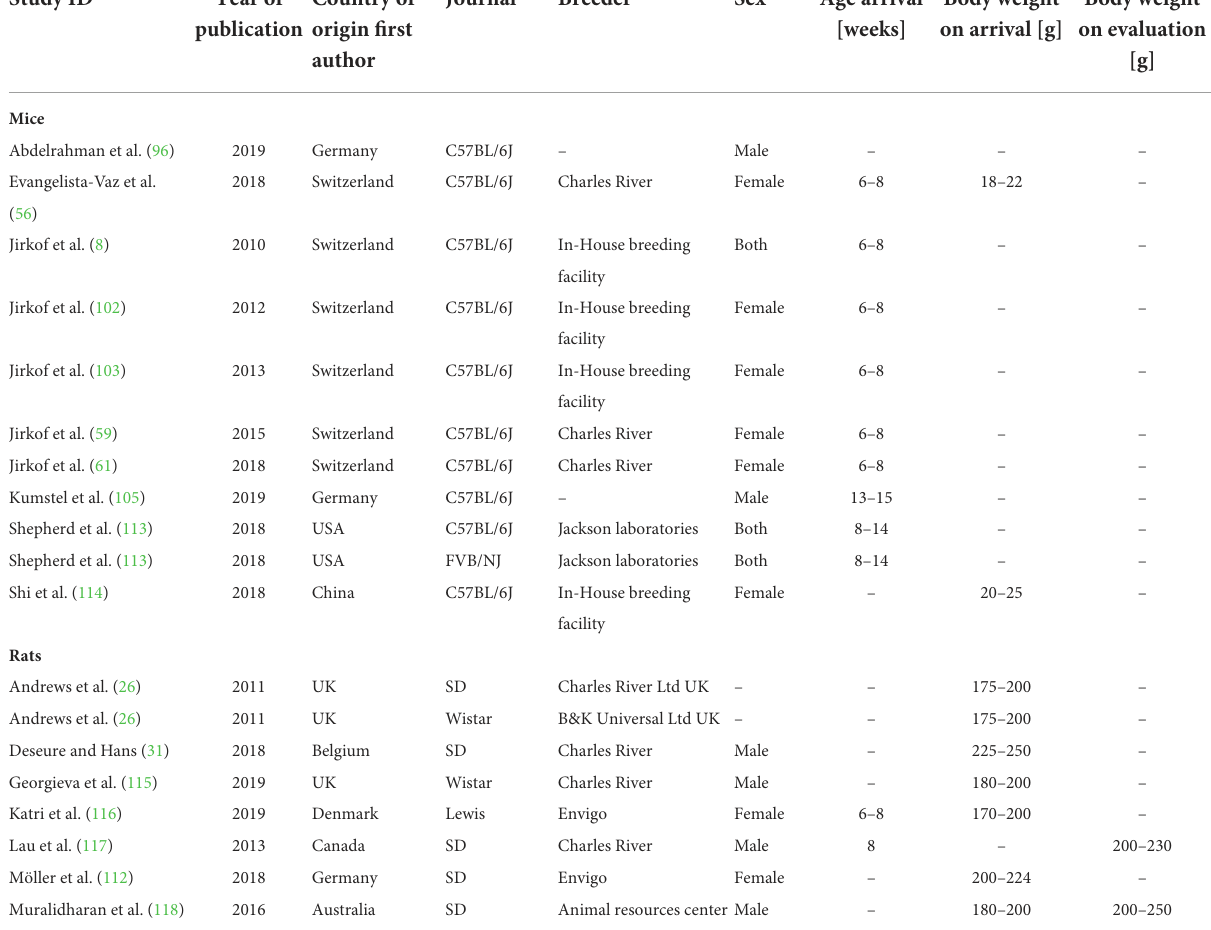
TABLE 8 Study and animal characteristics for burrowing mice (k = 10 studies) and rats (k = 7